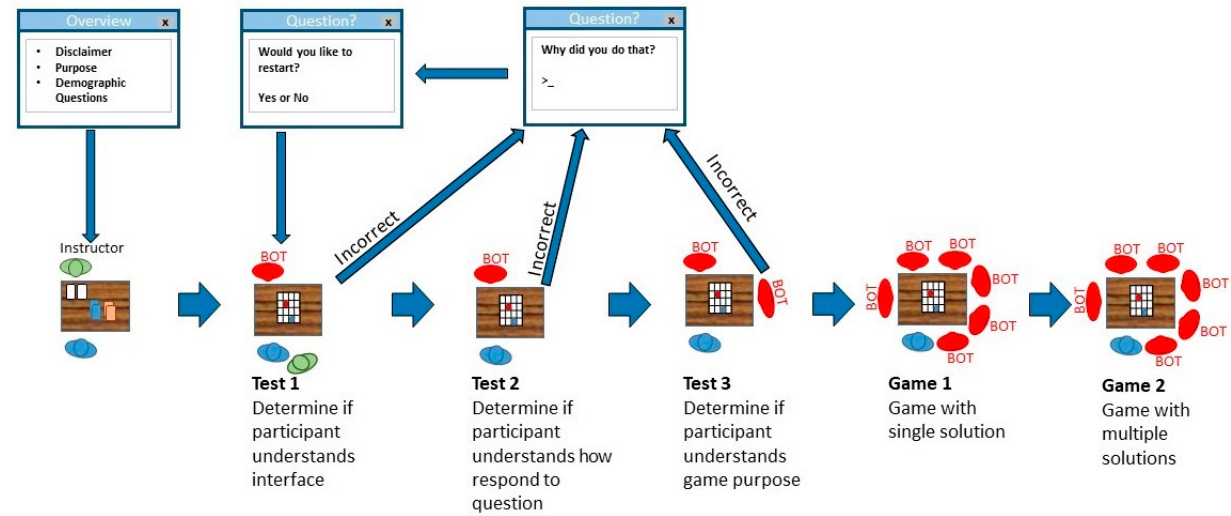
Figure 4. Flow diagram of a trial’s protocol involving a human subject with computer interaction.